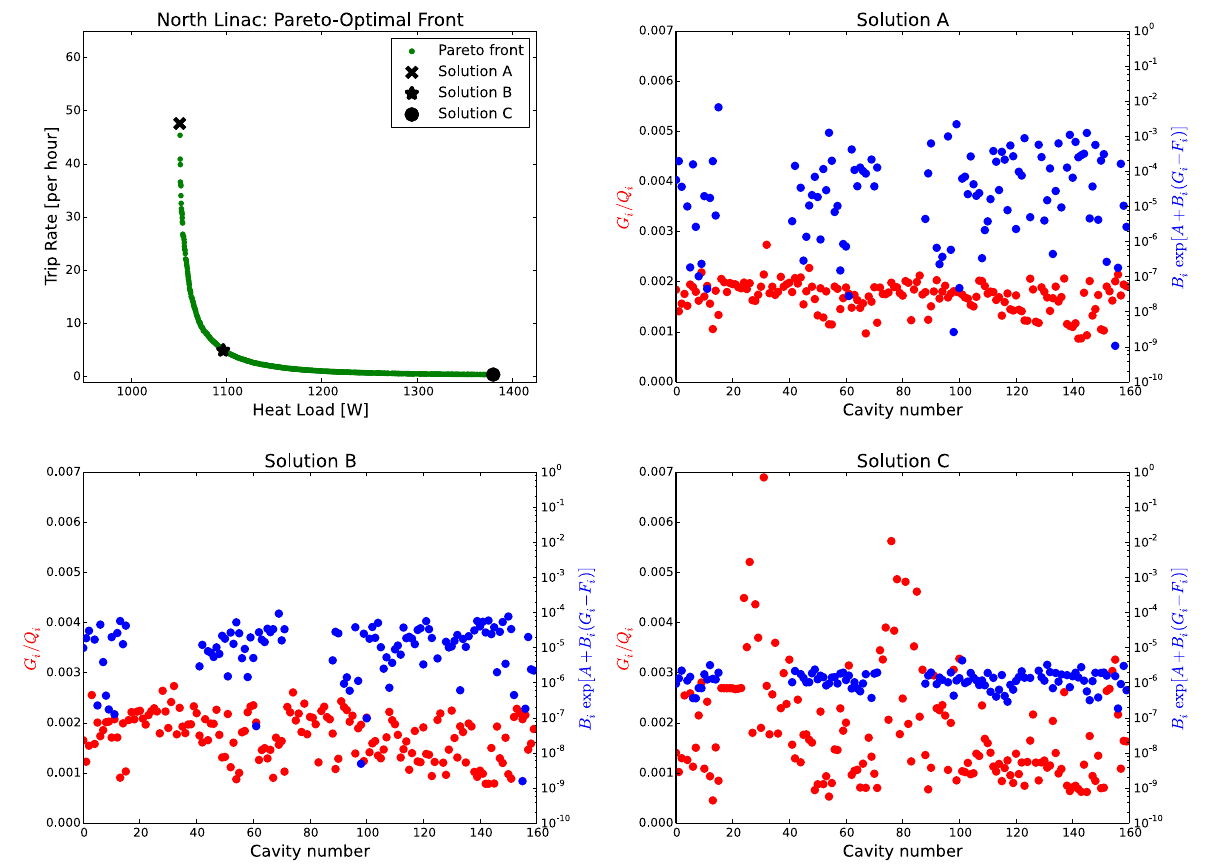
FIG. 5. Pareto-optimal front for North linac obtained using the GA simulation with 512 individuals evolved for 16000 generations (top left panel). Two of the three solutions marked are closely related to the asymptotic solutions obtained by single-objective minimization of the heat load only (solution A) and trip rates only (solution C). Also shown is a solution from the Pareto-optimal front which has a trip rate of exactly five (solution B). The remaining panels show the single-objective conserved quantities for solutions A, B, and C, as in Fig. 1. Note the red outliers in the bottom right